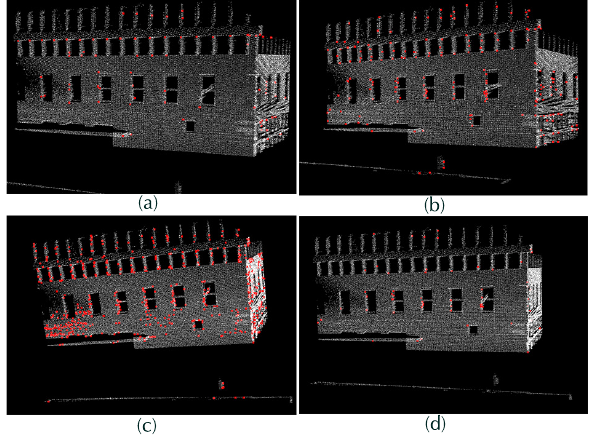
Figure 7. Harris keypoints in the point cloud. (a) keypoints in